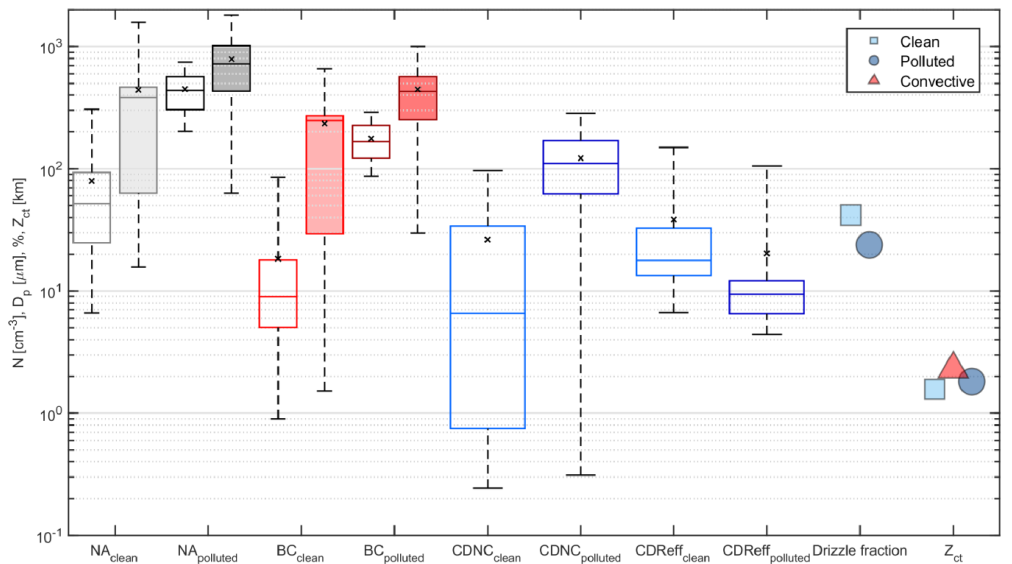
Figure 16. Statistical overview of aerosol and cloud properties. Total aerosol (NA, PCASP) and black carbon (BC, SP-2) concentration data are taken from cloud-free conditions (LWC < 0.01gm − 3 ). Aerosol data are shown for conditions broadly representative of the marine boundary layer ( Z < 1500m, unfilled boxes) and free troposphere (2500 > Z > 4000m, filled boxes). Cloud droplet number concentration (CDNC, CDP) and cloud droplet effective radius (CDReff, composite of CDP and 2D-S size distributions) are calculated using a minimum LWC threshold of 0.01gm − 3 . Drizzle fraction is the ratio of the total number of data points containing drizzle ( D > 100µm, drizzle water content > 0.01gm − 3 ) to in-cloud data points (total water content > 0.01gm − 3 ), expressed as a percentage. Cloud top altitude ( Z ct ) is the average value of cloud top determined from aircraft profiles. Convective cases ( Z ct > 2000m) are removed from the clean and polluted Z ct averages and displayed separately. All data have been split into clean (CO < 83ppb) and polluted (CO > 83ppb) conditions. Black markers indicate mean, box indicates interquartile range and median values, and whiskers present 5th and 95th percentiles.